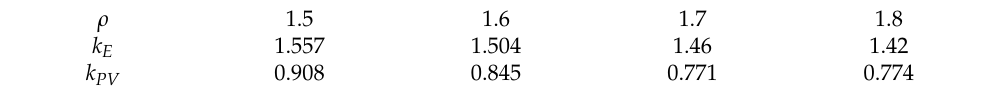
Table 4. Calculated parameters depending on ρ at m P = 0.568, m = 15.